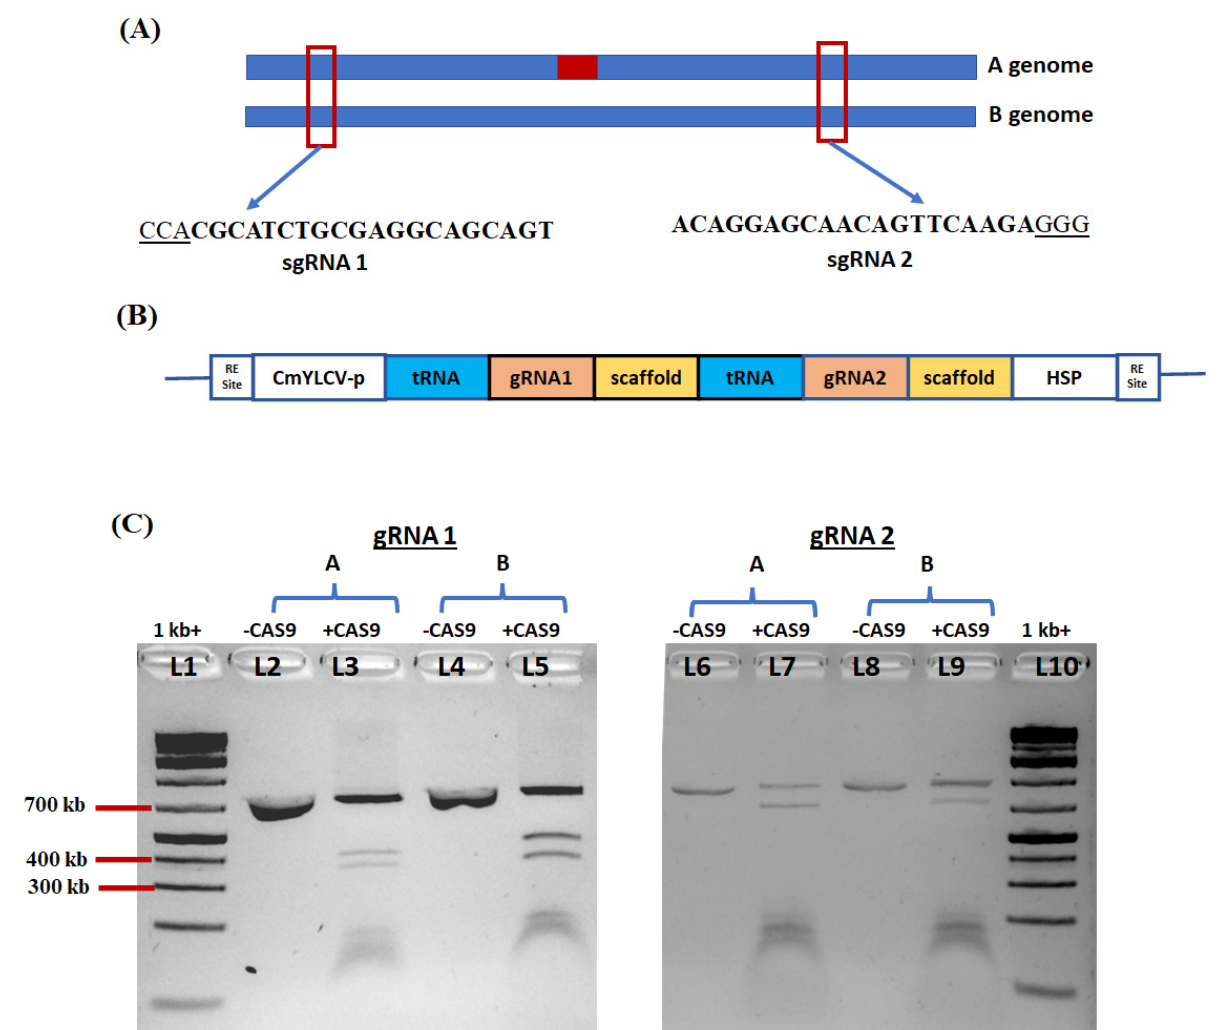
Figure 6. Schematic diagram of the peanut Ara h 2 target gene copies, tRNA–sgRNAs of Ara h 2 , and in vitro digestion of Ara h 2 gene targets: ( A ) schematic diagram representation of peanut Ara h 2 gene copies at A and B genome and gRNA target regions; ( B ) schematic diagram representation of tRNA–sgRNAs of Ara h 2; ( C ) in vitro digestion of Ara h 2 . L1 and L10: 1kb + ladders; L2: uncut Ara h 2A target region (genome A); L3: Ara h 2A target region digested with Cas9 and sgRNA1 (expected bands of 399 bp and 376 bp); L4: uncut Ara h 2B target region (genome B); L5: Ara h 2B target region digested with Cas9 and sgRNA1 (expected bands of 396 bp and 380 bp); L6: uncut Ara h 2A target region (genome A); L7: Ara h 2A target region digested with Cas9 and sgRNA2 (expected bands of 596 bp and 199 bp); L8: uncut Ara h 2B target region (genome B); L9: Ara h 2B target region digested with Cas9 and sgRNA2 (expected bands of 564 bp and 212 bp).